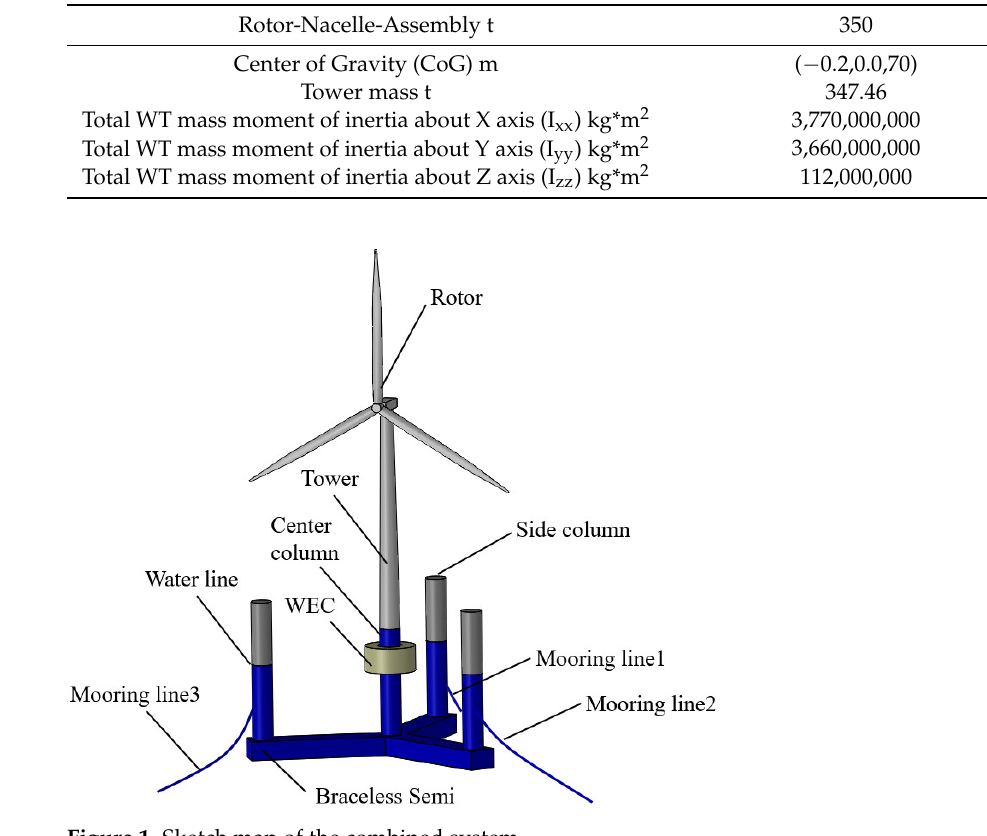
Figure 1. Sketch map of the combined system.